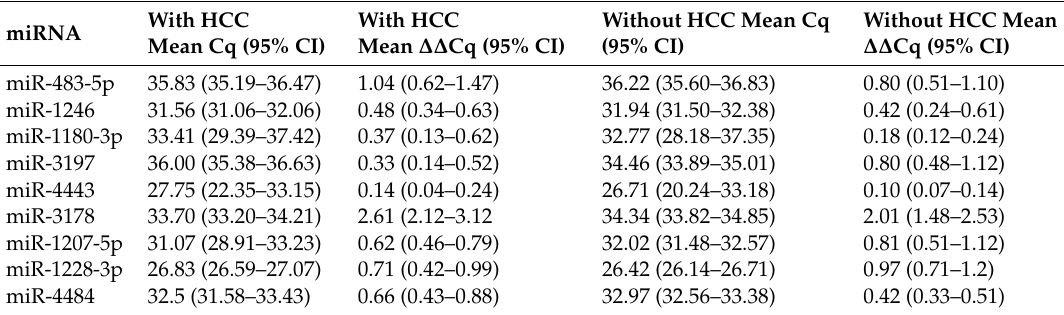
Table 2. Expression levels of the miRNA candidates in the two groups determined by qRT-PCR. With miRNA